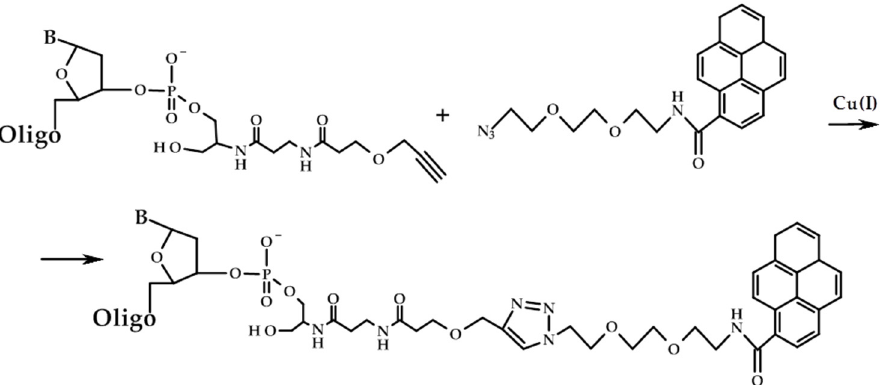
Figure 1. Scheme of the synthesis of 3’-pyrene